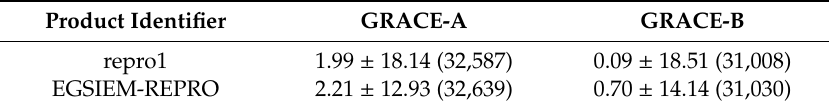
Table 3. Mean and standard deviation in mm of Satellite Laser Ranging (SLR) residuals for reduced-dynamic orbits over the entire year 2008. The number of used normal points in the analysis is given in brackets.